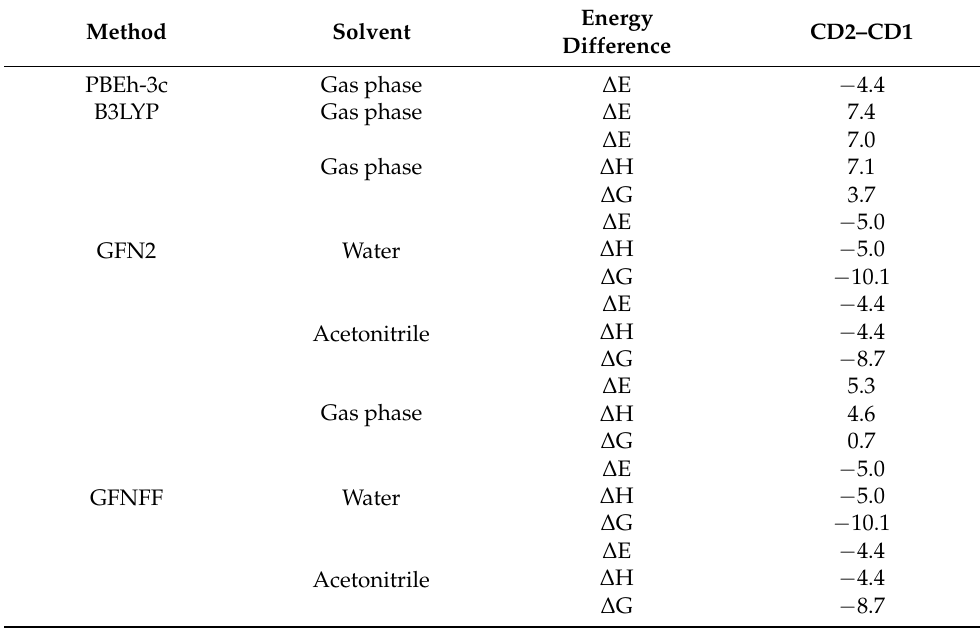
Table 3. Energy difference between stable CD